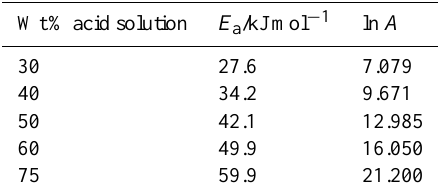
Table 1. Measured activation energies ( E a ) and pre-exponential fac- tors ( A) for the reaction rate coefficient for the dissolution of amor- phous fayalite (Fe 2 SiO 4 ) powder in H 2 SO 4 /H 2 O solutions of vary- ing